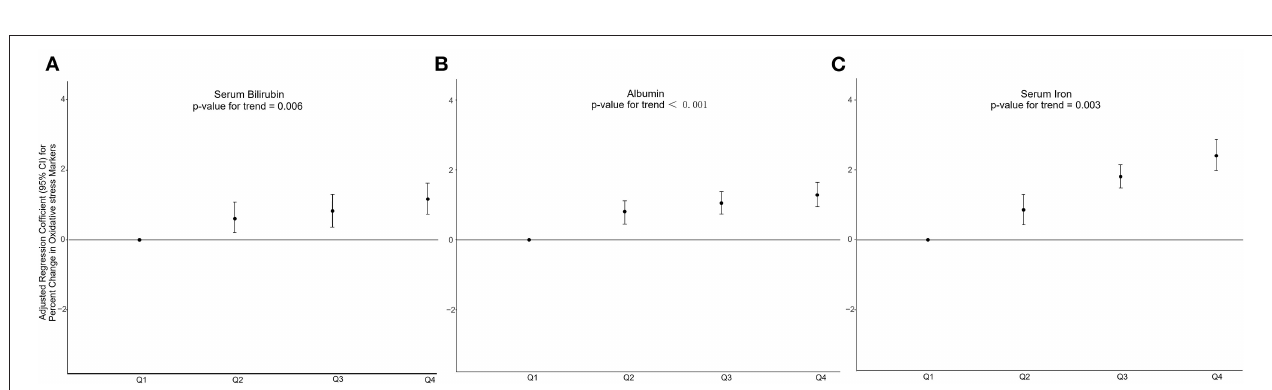
FIGURE 4 | Percent change in inflammatory markers associated with increasing C-DII among study participants in model 3 for (A) lymphocyte count, (B) neutrophil count, (C) ferritin (D) CRP, (E) alkaline phosphatase. Model 3 adjusted for age, sex, race/ethnicity, cotinine exposure status, BMI, poverty-income ratio, body fat percentage and energy intake.